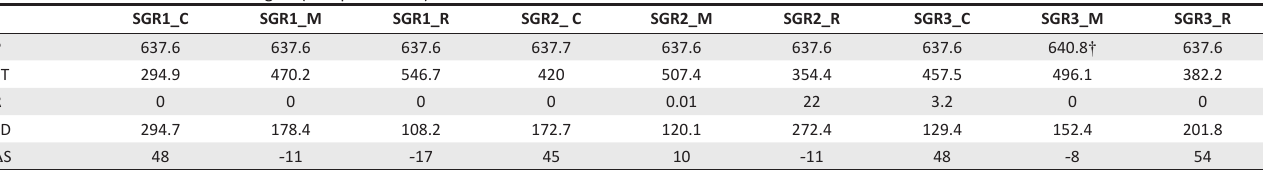
TABLE 5: Catena element water budgets (mm per